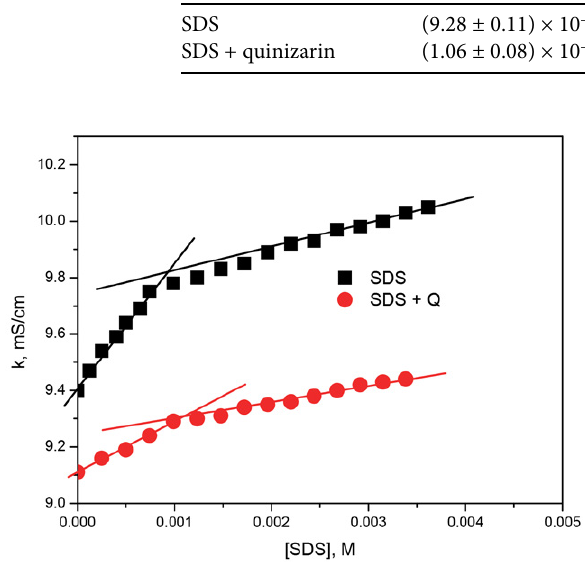
Figure 8. Plots of electrical conductivity versus SDS concentration in the absence and the presence of quinizarin at 293.15